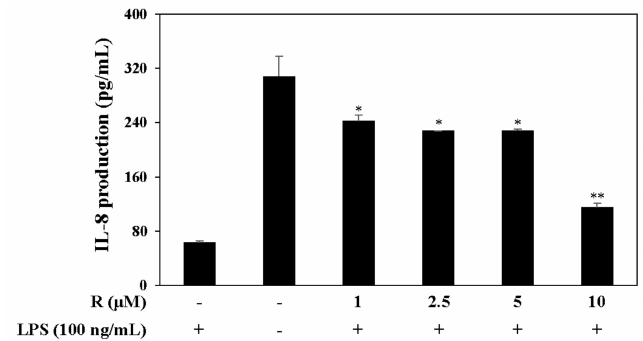
Figure 8. E ff ect of R on IL-8 expression. HT-29 colon epithelial cells were pretreated with R for 2 h and stimulated with LPS (100 ng / mL) for 12 h. The levels of IL-8 in the culture media were measured by ELISA. The data are represented as the mean ± SD. * p < 0.05, ** p < 0.01, vs. LPS-treated